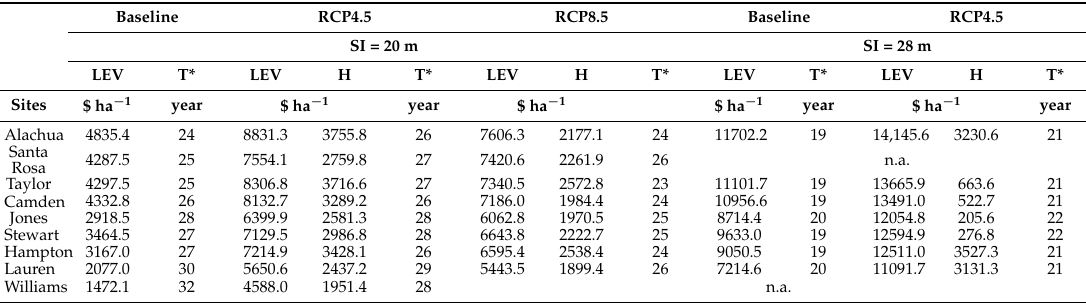
Table 4. Land expectation value (LEV), monetary value of increased water yield (H), and optimal harvest age (T*) in all loblolly pine sites with SI = 20 m and 28 m and PD = 750 trees ha − 1 for all climatic scenarios. Baseline RCP4.5